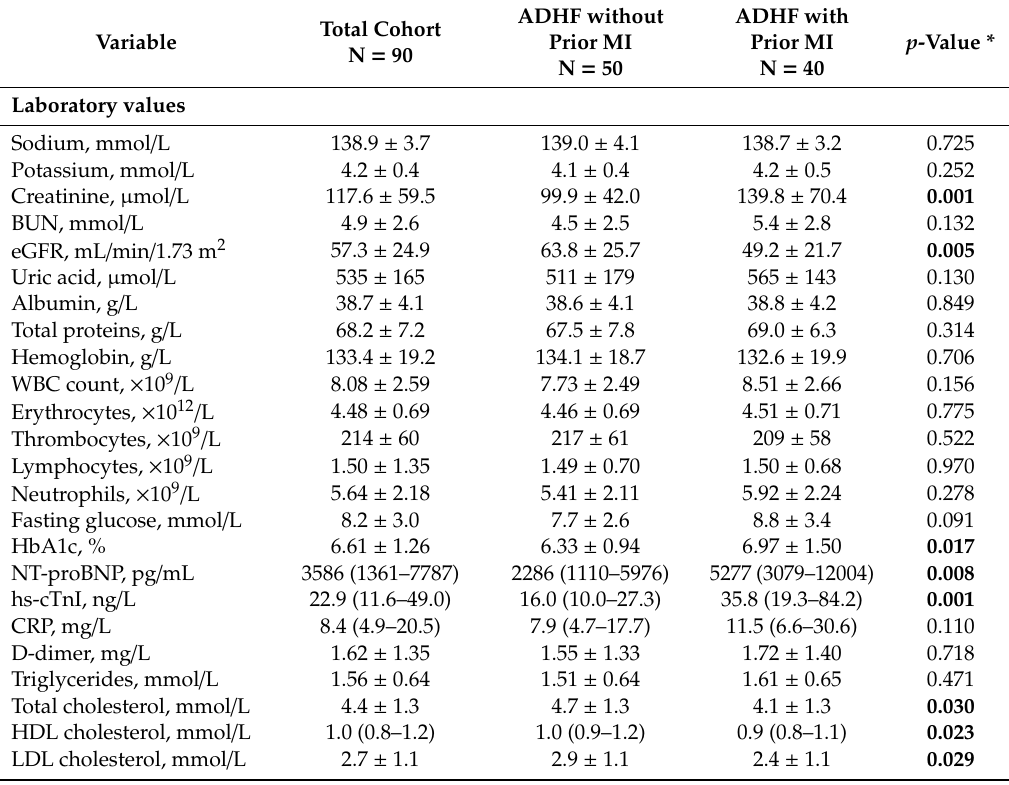
Table 2. Laboratory data of the enrolled cohort stratified by the history of myocardial